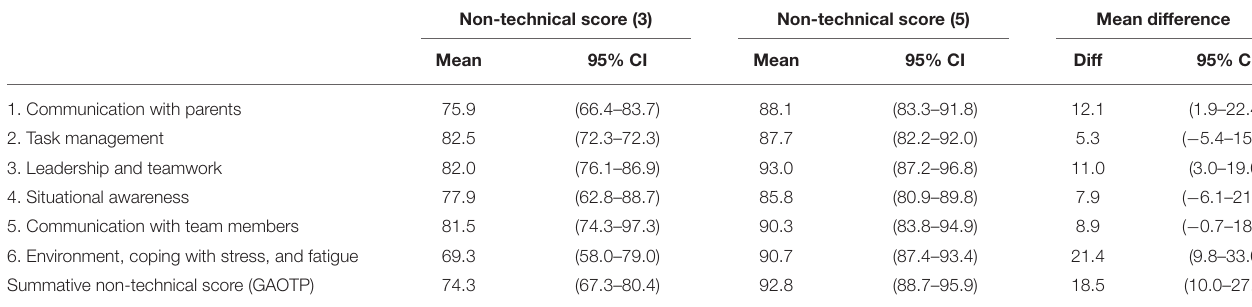
TABLE 3 | Mean difference in clinical performance between non-technical score